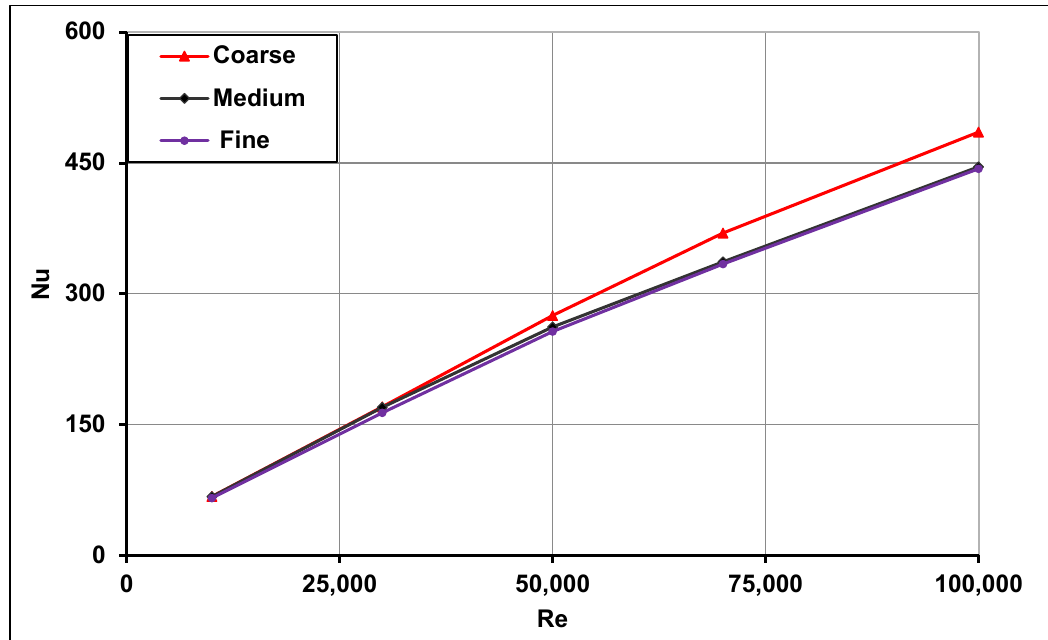
Figure 6. Mesh independence study for a typical receiver without inserts.